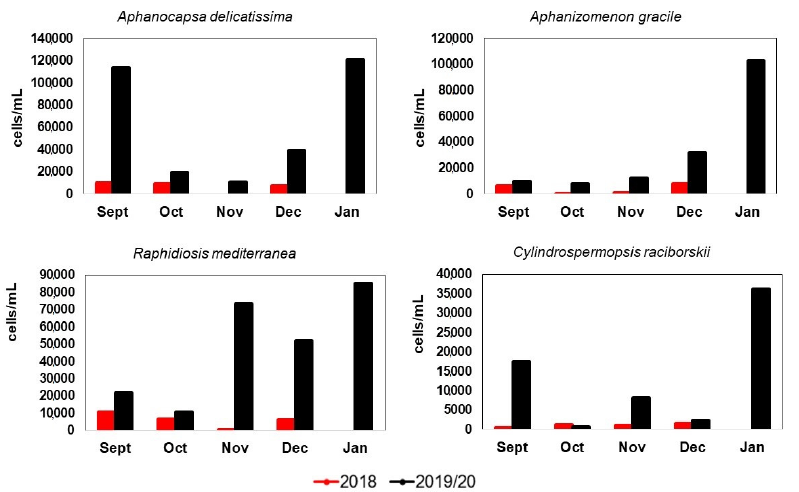
Figure 5. Abundance dynamics of the most abundant species in 2018, 2019, and January 2020. Scales differ between charts.